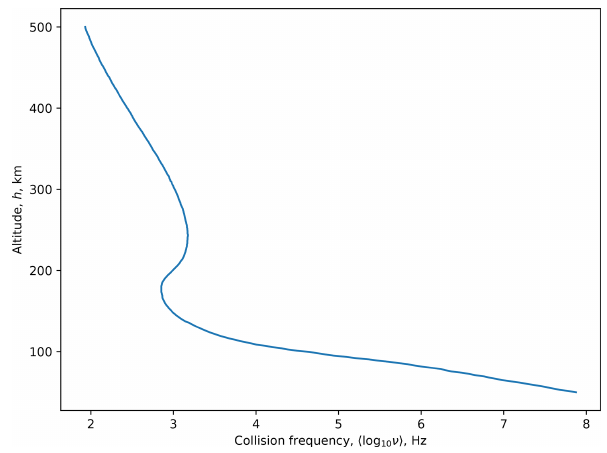
Figure 1. The model of electron collision frequency ν = ν en + ν ei from Aggarwal et al.